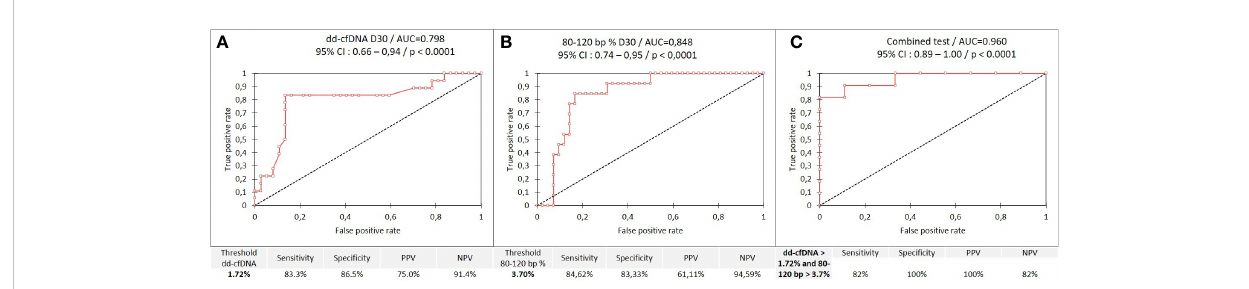
FIGURE 4 ROC curves; (A) , %dd-cfDNA between not-injured and injured graft patients (B) , %80-120bp size between not-injured and injured graft patients and (C) , combined test between infected and uninfected groups.